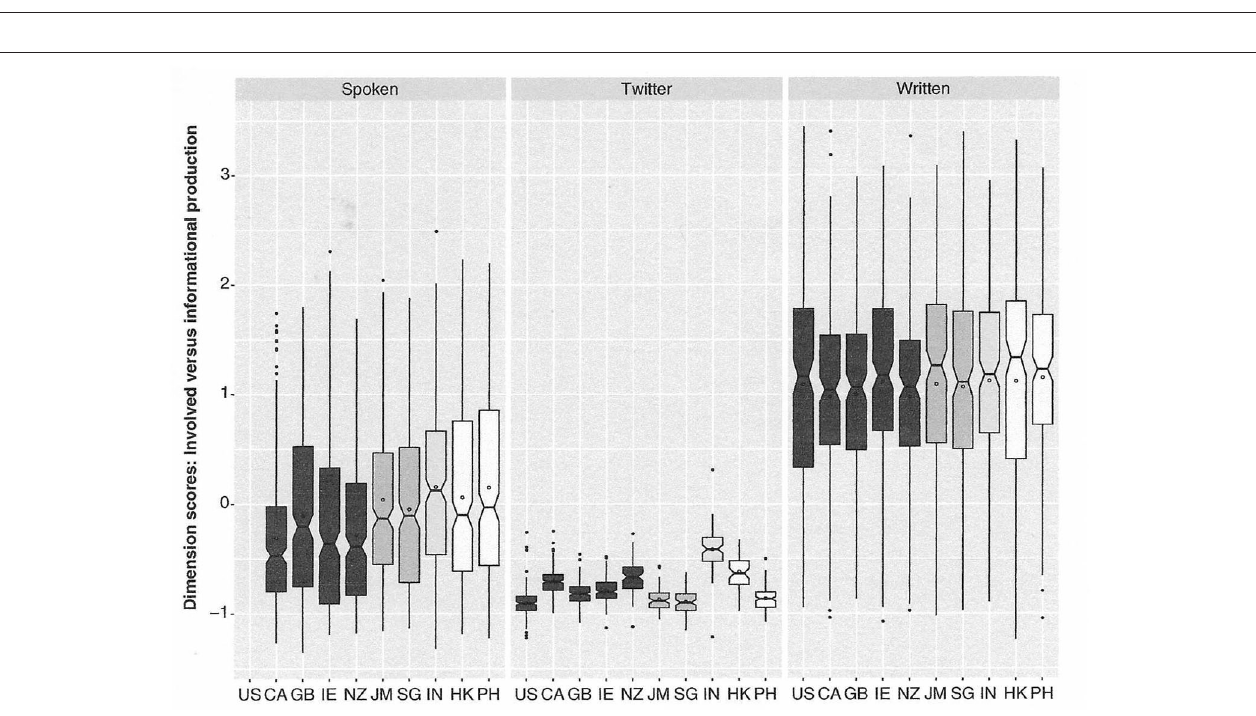
FIGURE 21 | Distribution of boycott(s) in the GloWbE Corpus (from https://www.english-corpora.org/glowbe/).